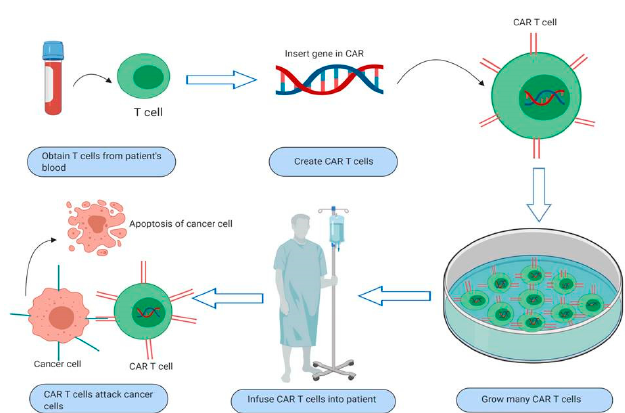
Figure 1. Overview of chimeric antigen receptor (CAR) T-cell therapy. Process of extracting normal T-cells from the patient’s peripheral blood; integration of CARs in T-cells in the laboratory; in vitro cultivation and expansion of CAR T-cells that are re-infused into the patient’s bloodstream; CAR T-cells proliferate and kill the tumor cells that bear the specific antigen the CARs are directed against.